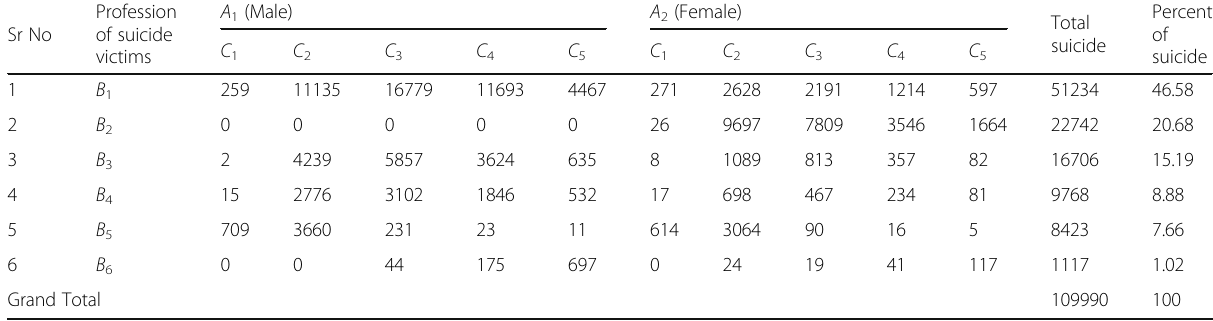
Table 9 Distribution of incidences of suicides according to the profession during 2013